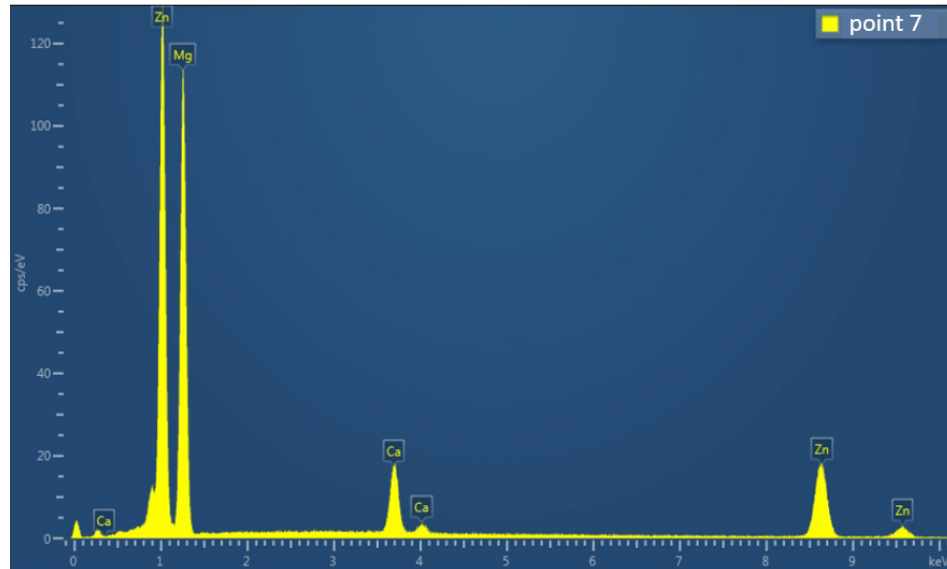
Figure 4. Exemplary EDS analysis of point 7 indicated in Figure 3, for a Mg5Zn0.3Ca sample. Intensity peaks (counts/s) for different energies (eV) correspond to EDS signals from Ca, Zn, Mg, Ca, Ca, Zn, and Zn again (in sequence from left to right).